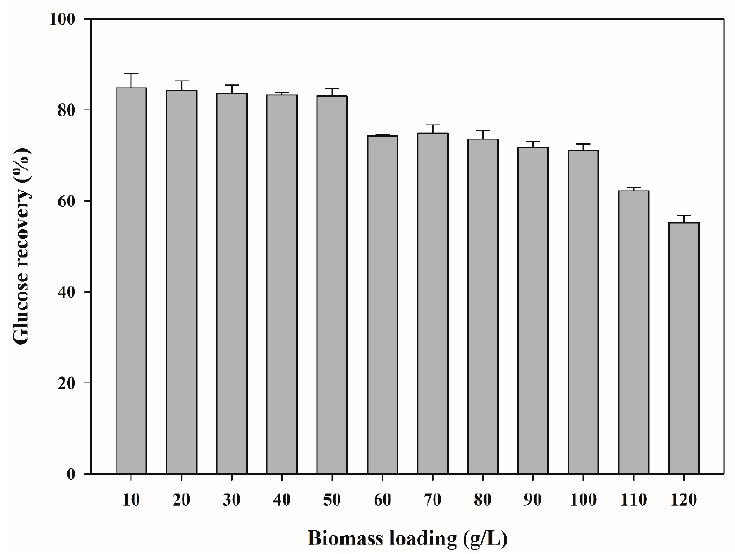
Figure 2. Effect of biomass loading on glucose recovery from whey powder.